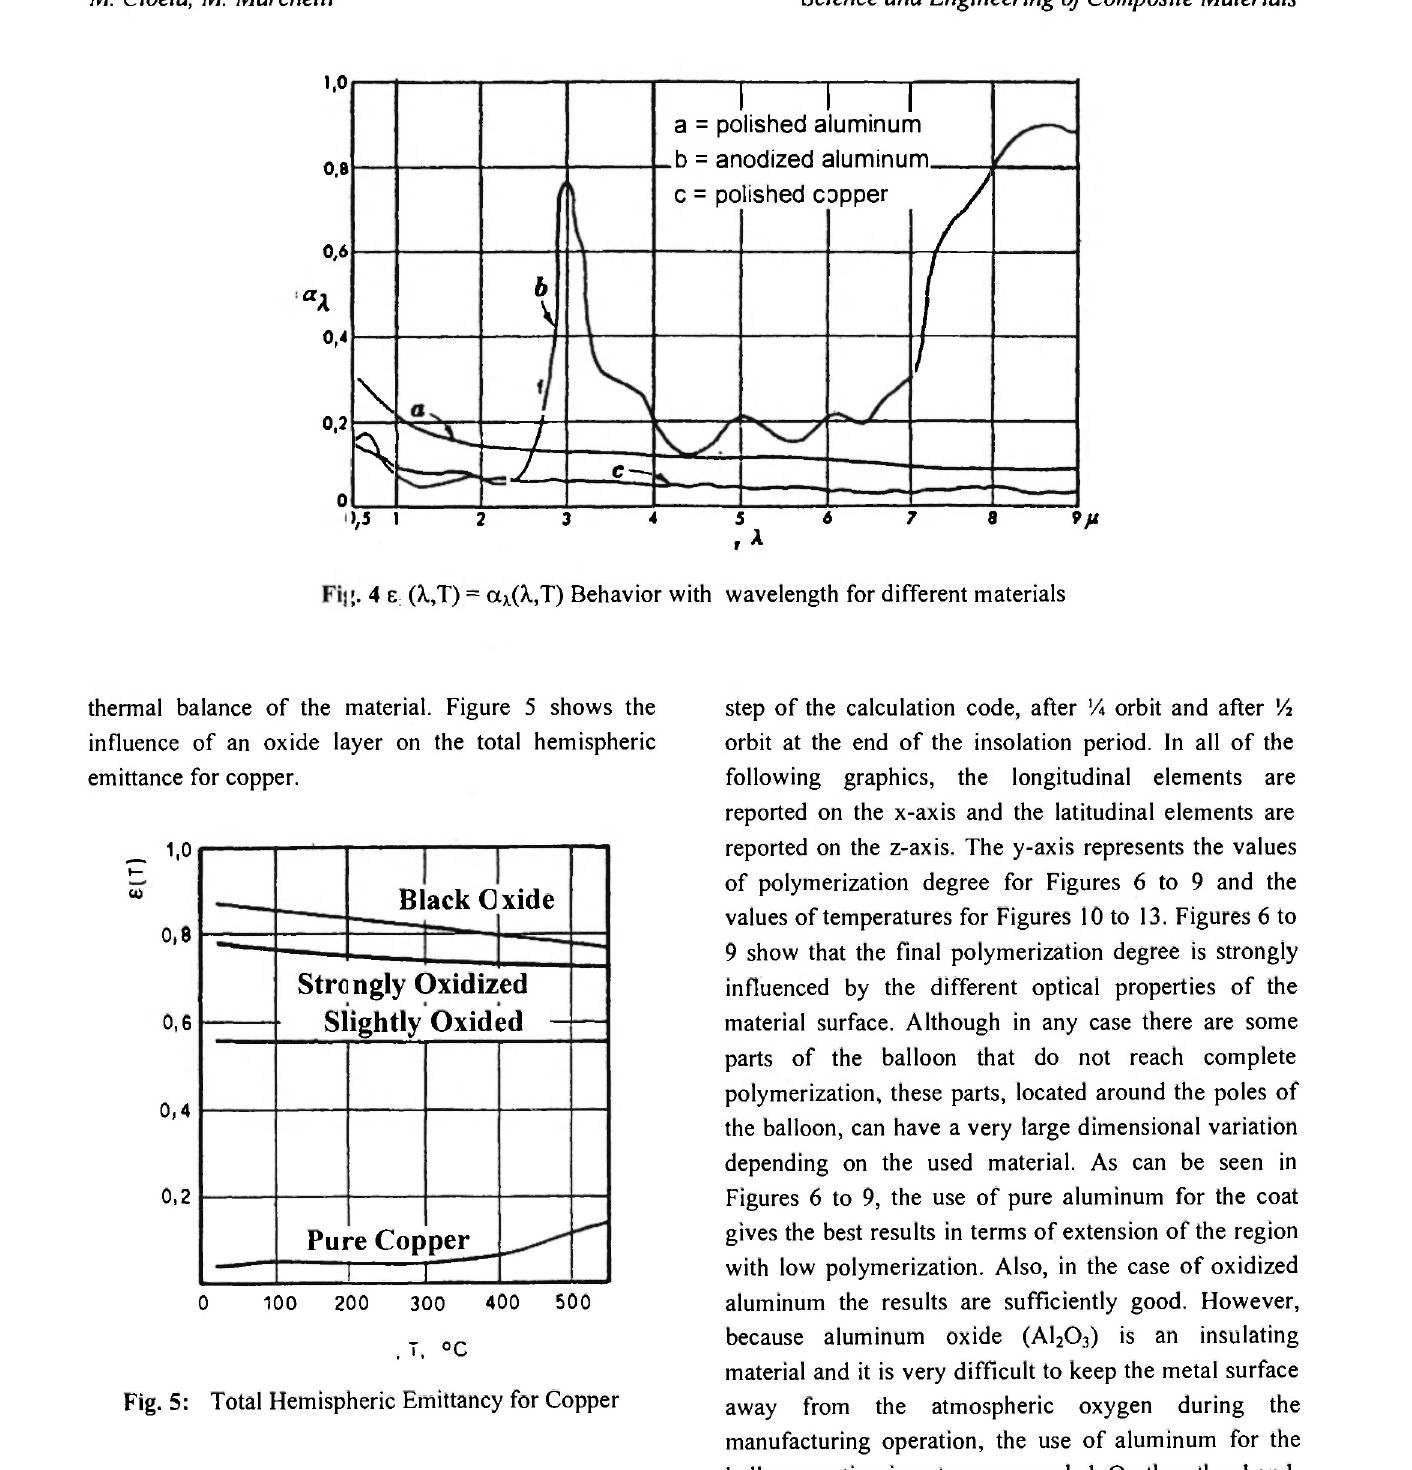
Fig. 5: Total Hemispheric Emittancy for Copper